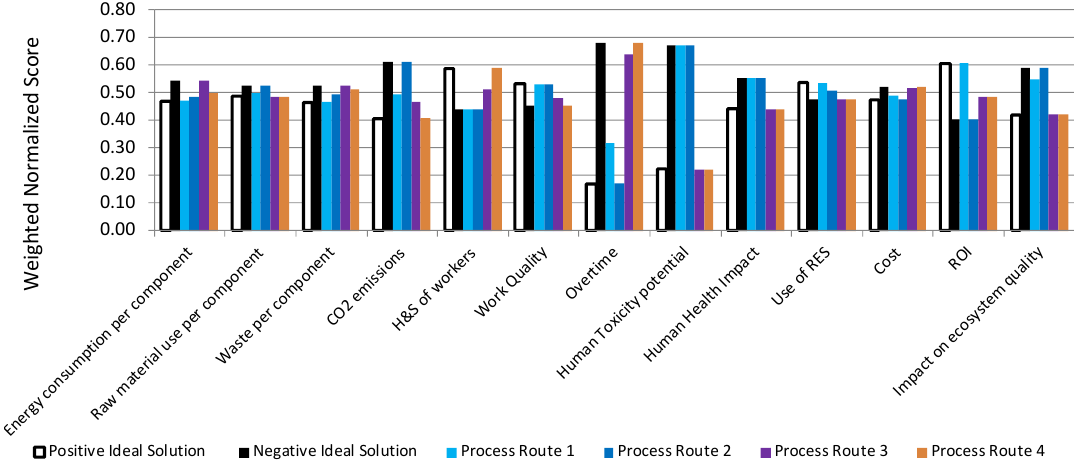
10 Table 4. Normalized matrix. Process Route 1